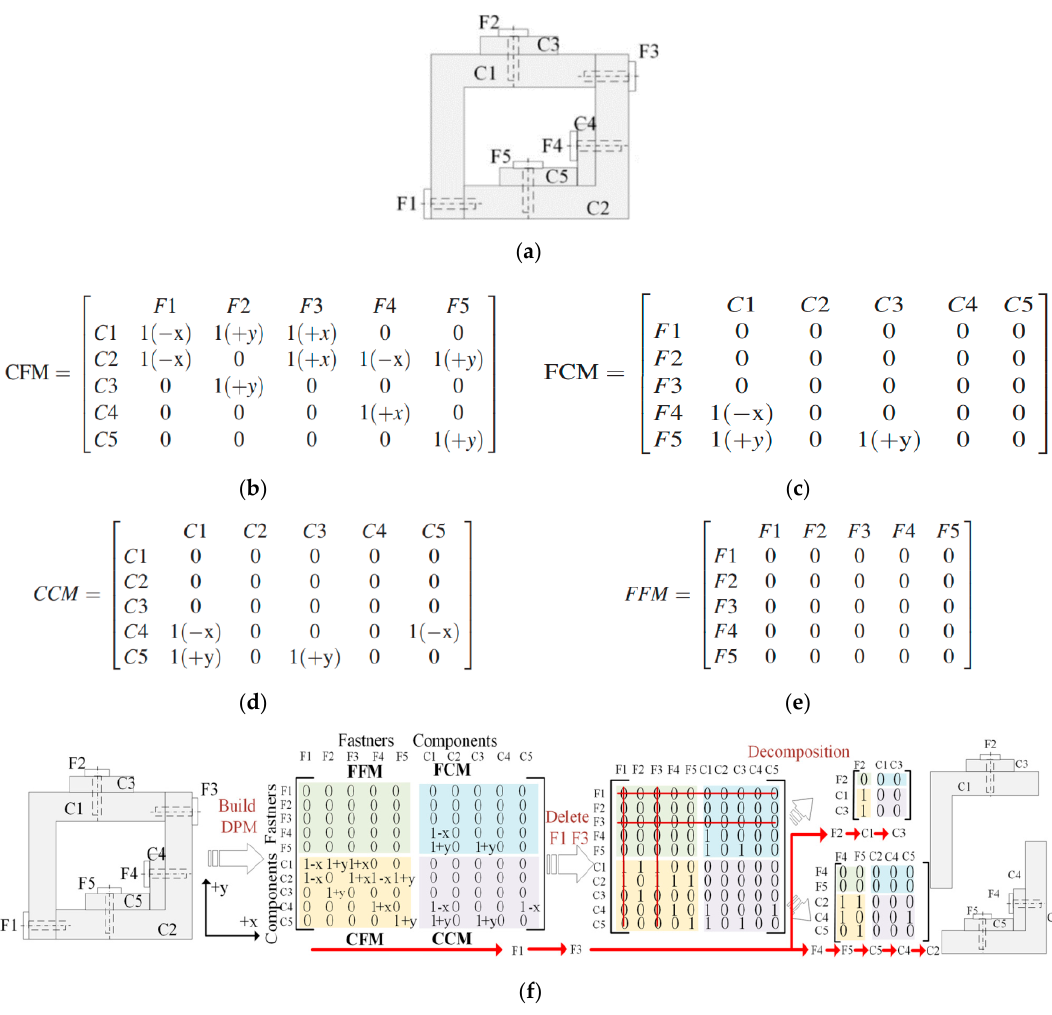
Figure 5. ( a ) Example application 2nd method; ( b ) example of 2nd method: CFM creation; ( c ) example of 2nd method: FCM creation. ( d ) Example of 2nd method: CCM creation; ( e ) example of 2nd method: